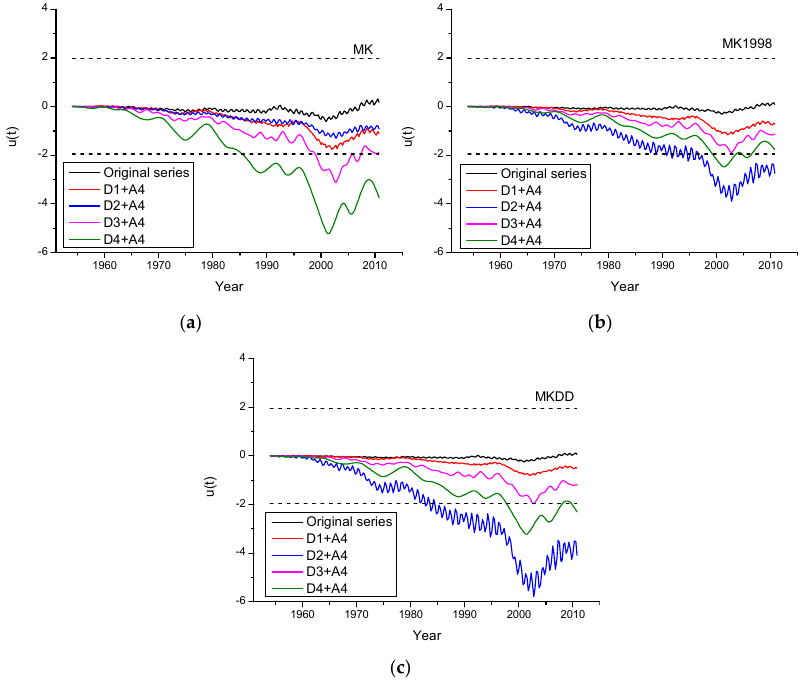
Figure 13. Three sequential Mann-Kendall graphs of seasonal total precipitation series exhibiting the progressive trend lines of each detail component (with the addition of the approximation) with respect to the original series. The upper and lower dashed lines represent the confidence limits ( α = 5%). ( a ) MK; ( b ) MK1998; ( c ) MKDD.